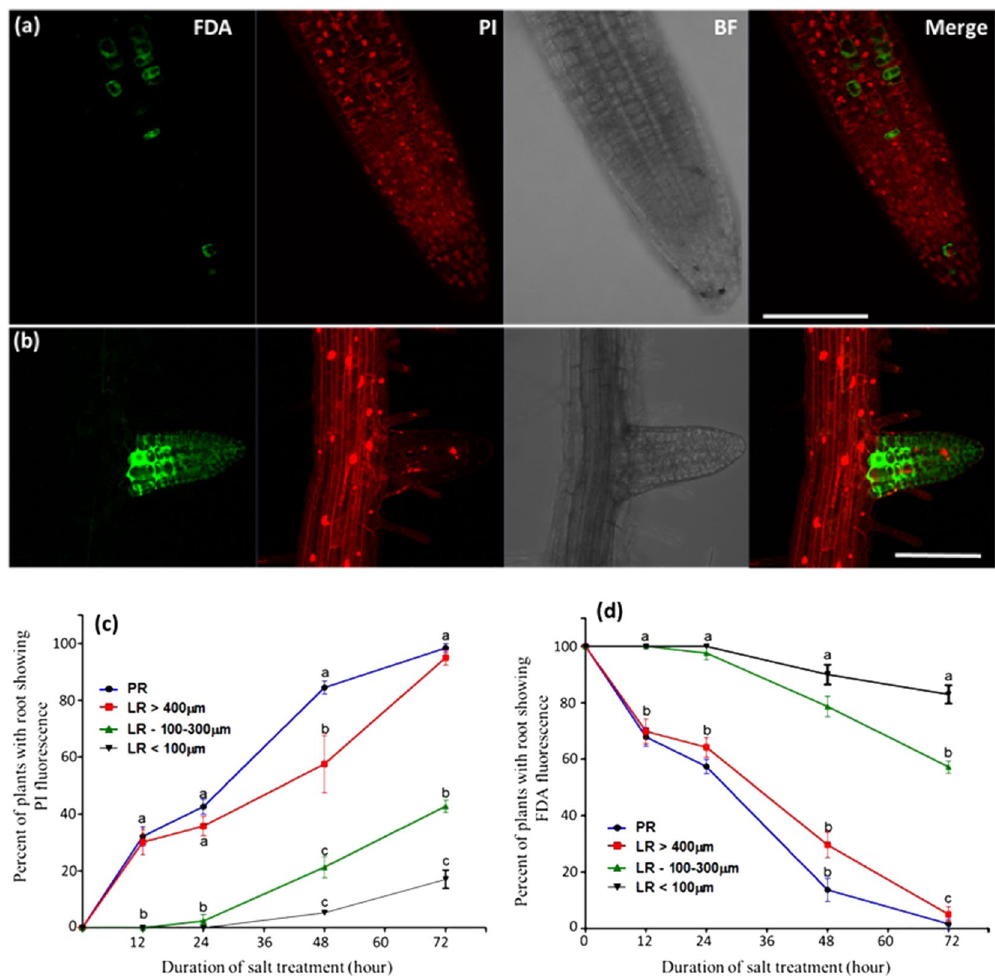
Figure 1. Viability of the PR and the LR during lethal salinity. Seven day old WT Arabidopsis seedlings were subjected to salt stress (200 mM NaCl + 1/2 MS) for 12, 24, 48 and 72 h and then stained with FDA + PI. Shown are representative confocal images of: ( a and b ) WT plants stained with FDA + PI in the PR and LR positions. The presented confocal images were captured after 48 hours of stress. Scale bars = 50 µ m. ( c and d ) Graphical display of the confocal images presented in ( a ) and ( b ) during 0, 12, 24 and 72 hours of salt stress. The colored lines in the graphs indicate LR lengths (in µ m). The experiments were repeated three times (n = 20 plants in each time point in all the experiment ± S.E.). Statistical analysis was done by Tukey’s Honest Significant Difference test (at P < 0.05) for each time point separately. (Significant differences are indicated by small letters). The shown images are projection of the entire z-stack at maximum intensity. The complete Z stack of the individual of the presented images can be found in Figs. SI1, SI2. Confocal images of non-stressed plants can be found in Fig.